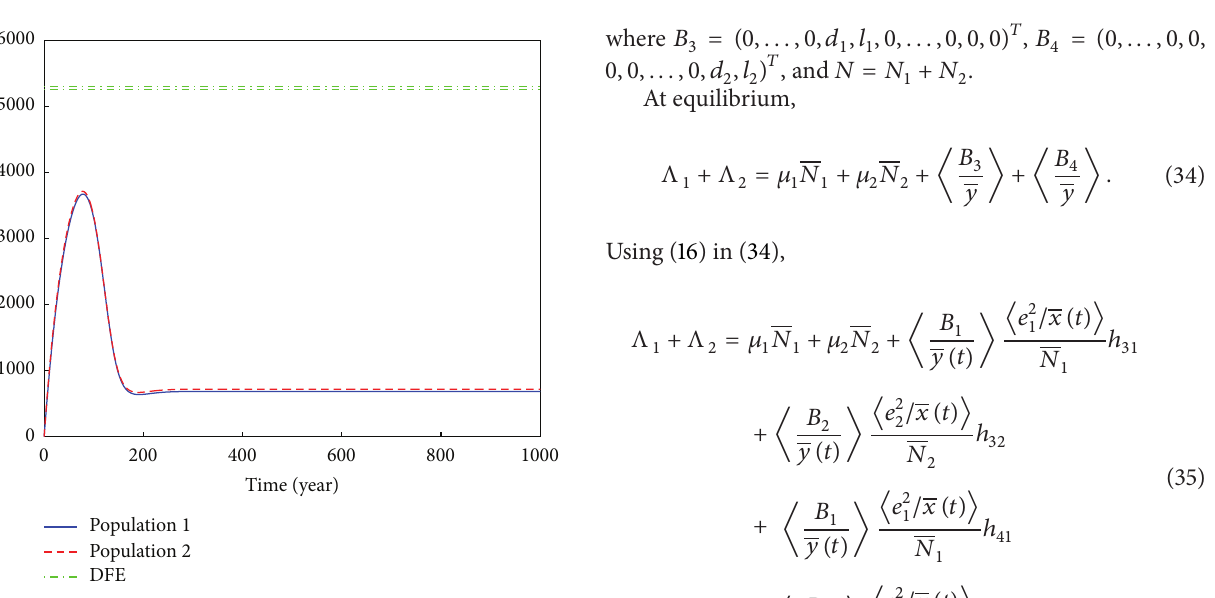
Figure 5: Trajectories of susceptible individuals of (1) for different initial conditions when 𝛽 1 = 0.002 and 𝛽 2 = 0.003 (such that = 0.3691 and 𝑅 2 = 0.4980 ). The DFE coexists with endemic 𝑅 1 0 0 equilibrium and is locally stable when 𝑅 0 < 1 . All other parameters are as in Table